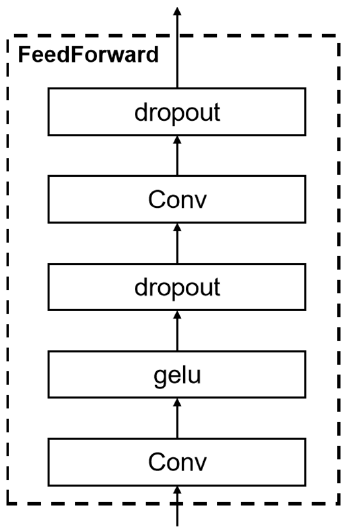
Figure 6. The structure of the Feedforward layer.